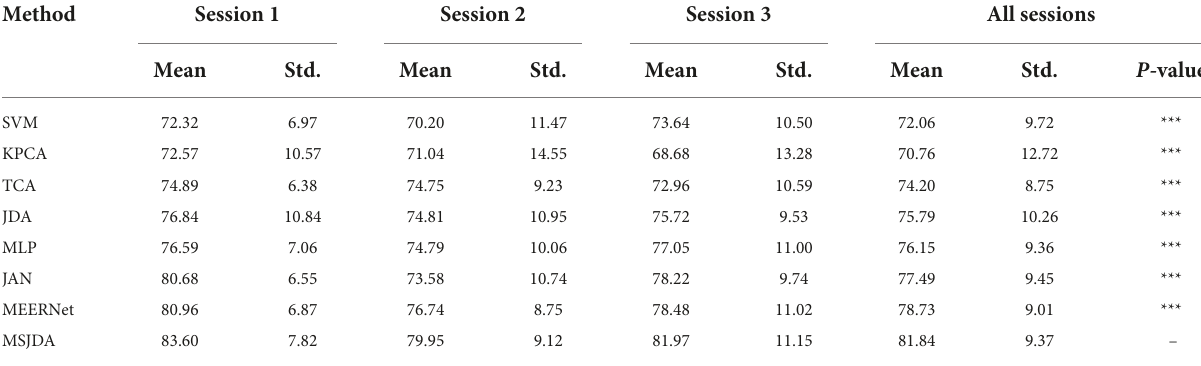
TABLE 1 Average results of cross-subject experiments (%).